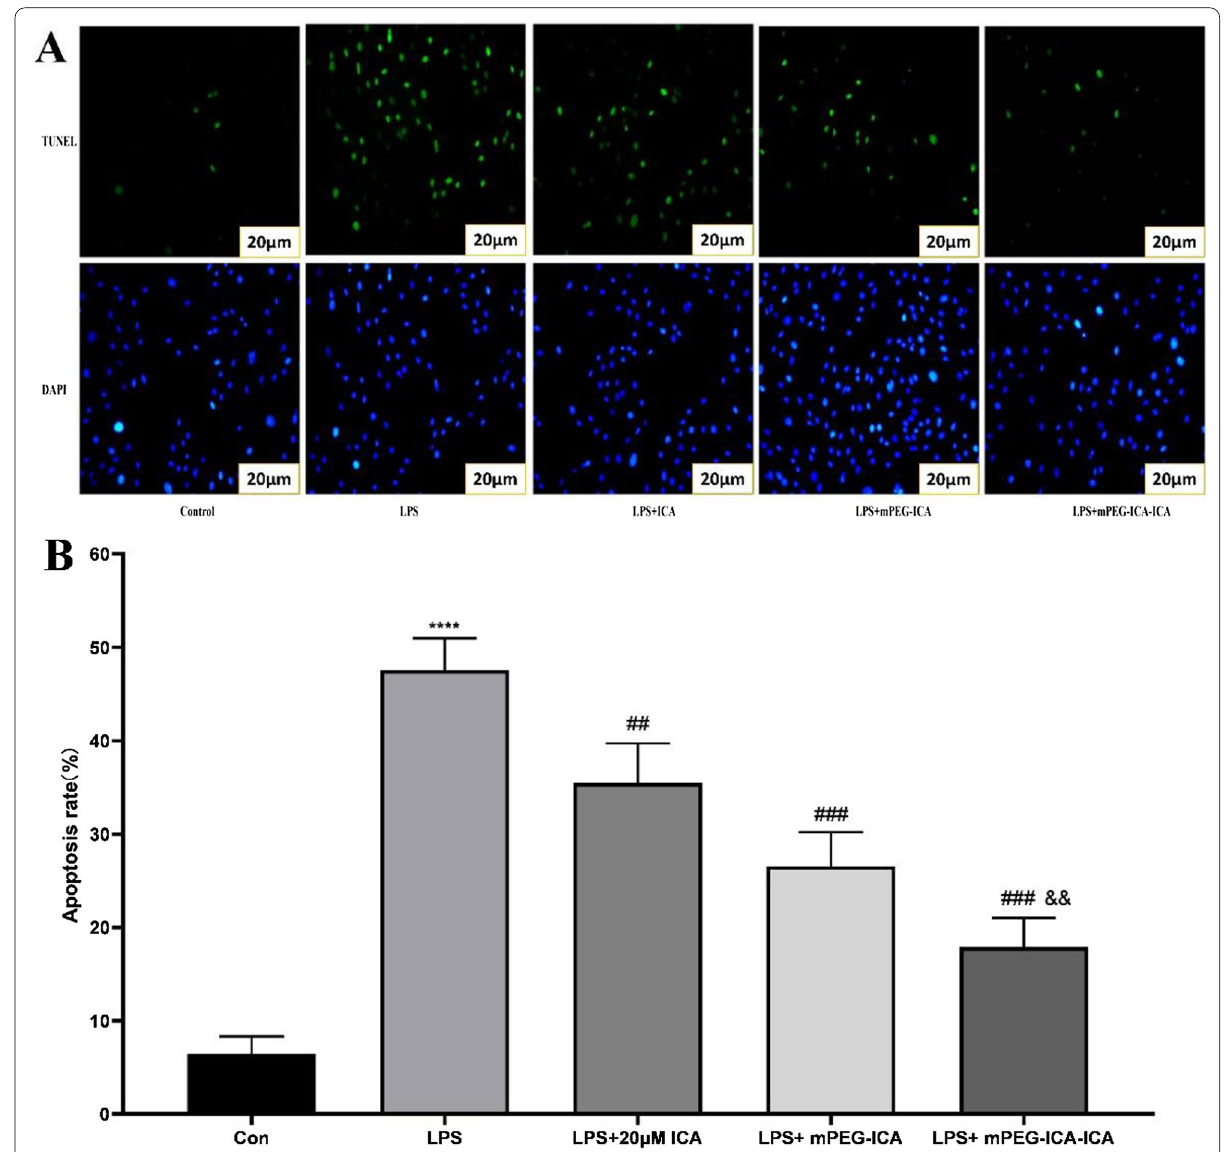
SEM (**** P < 0.0001 vs . con; ±